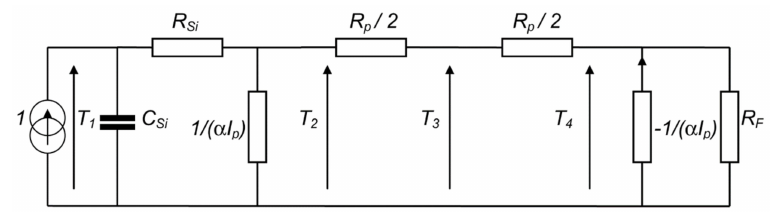
Figure 6. Network in relation to the reciprocity